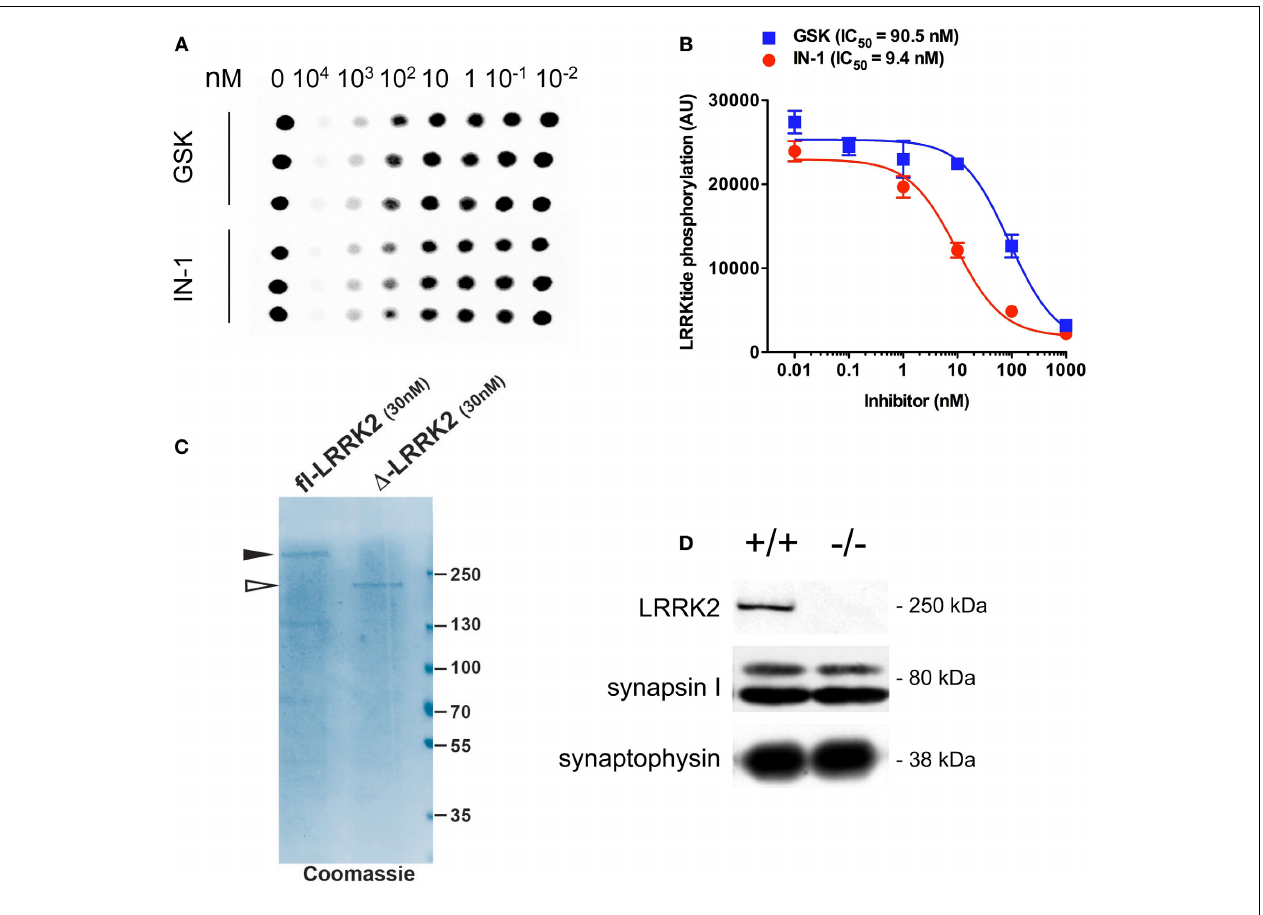
FIGURE A1 | IN-1 and GSK inhibit LRRK2 activity in vitro . (A) Recombinant GST-LRRK2 970 − 2527 was incubated with increasing concentrations of LRRK2 inhibitors IN-1 or GSK in the presence of 500 µ M LRRKtide and 100 µ M ATP (0.5 µ Ci 33 P-ATP). Reactions were spotted onto P81 phosphocellulose paper and LRRKtide radioactivity quantified by phosphoimaging scanner. (B) Dose- response curves and calculation of IC50 values indicates that both